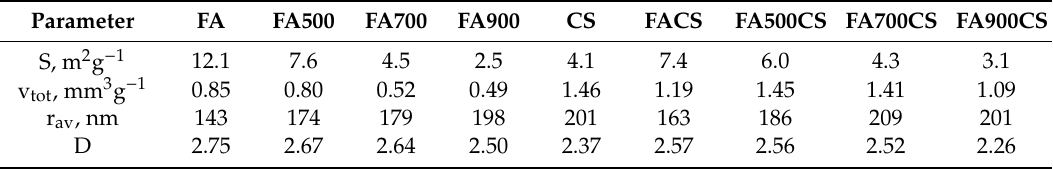
Figure 3. Fractal plots for the studied sorbents (the points are connected to guide the eye). The slope of the linear fits is the highest for CS and the lowest for FA adsorbent. Broad fractality ranges for fly ashes shorten after chitosan modification. Table 1 summarizes numerical values of surface parameters of the studied adsorbents derived from the isotherms. Table 1. Surface parameters of the studied adsorbents: S surface area, v tot nanopore volume, r av average nanopore radius, D surface fractal dimension.